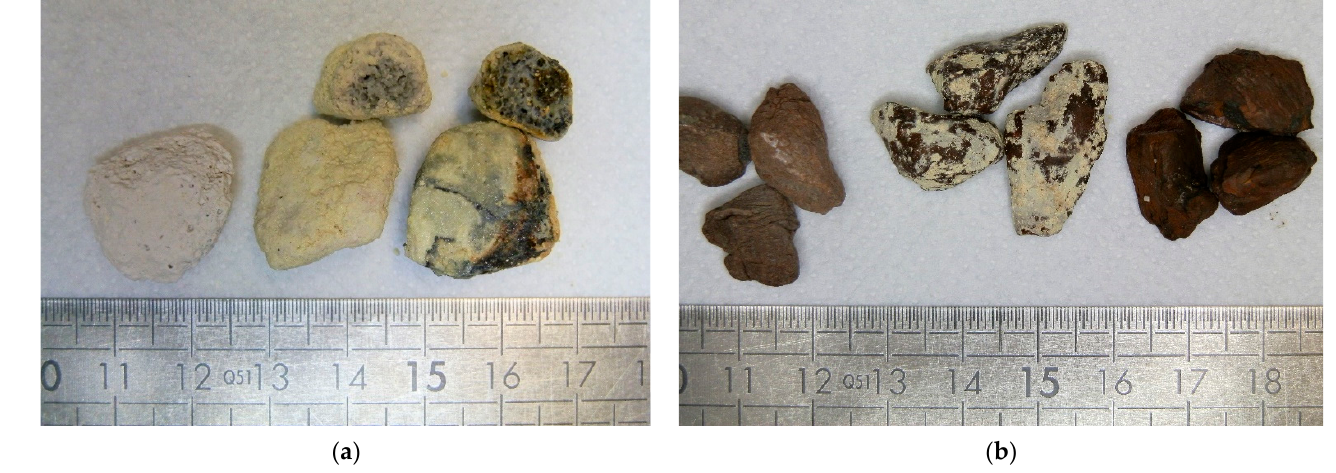
Figure 8. Change in aspect of both packing materials over time; ( a ) Cellular concrete waste (left to right: blank material, extracted from the top of the abiotic filter, extracted from the bottom); ( b ) expanded schist (left to right: blank material, extracted from the bottom of the biotrickling filter, extracted from the top).